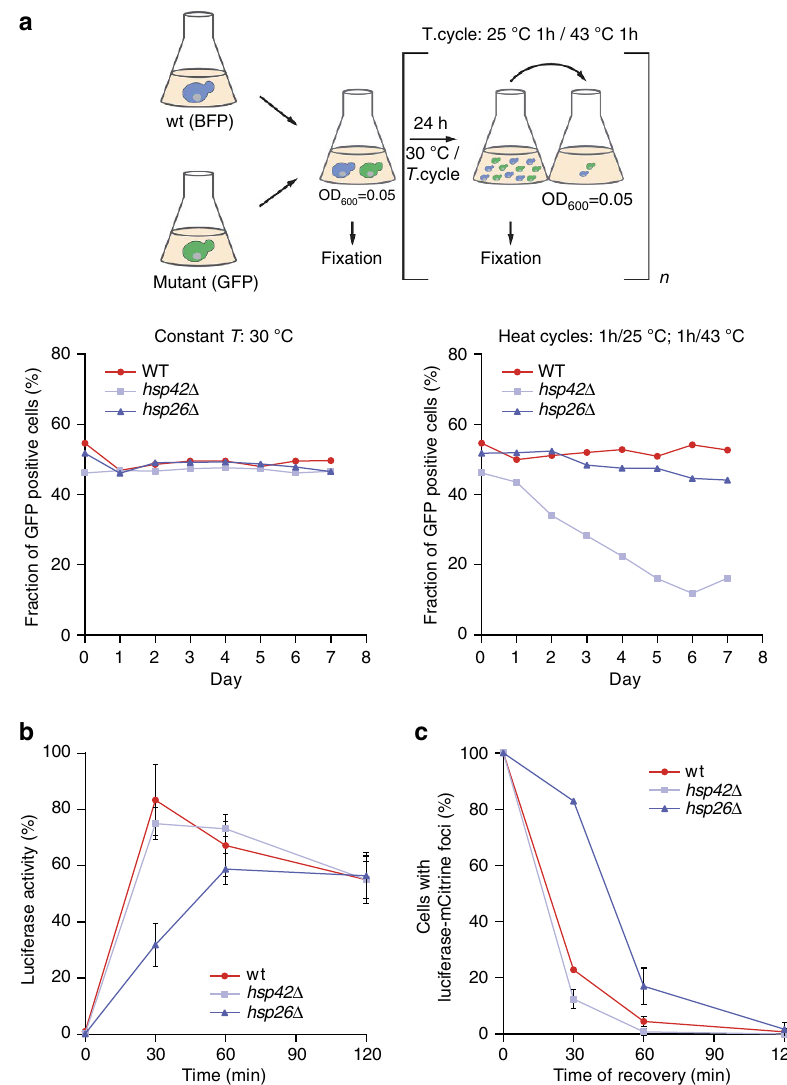
Figure 6 | Hsp26 accelerates protein recovery from aggregates and Hsp42 is beneficial for cell survival. ( a ) WTcells, expressing BFP, and respective mutant cells, expressing GFP, were grown to mid-log phase, mixed 1:1 and diluted to OD 600 0.05. The mixed culture was equally split and both were grown for seven days with daily dilutions to OD 600 0.05. One culture was grown at 30 (cid:2) C (left), the other culture was subjected to temperature cycles switching between 1h at 25 (cid:2) C and 1h at 43 (cid:2) C (right). Each day the proportion of WT and mutant cells was measured by monitoring the fraction of GFP- and BFP-positive cells by FACS analysis. ( b ) Effect of Hsp26 on luciferase recovery. Cells expressing yEMCitrine-luciferase in the respective genetic backgrounds were subjected to heat shock and allowed to recover. The graph shows the luciferase activity during recovery at 30 (cid:2) C. Cycloheximide was added before the heat shock. Mean and s.d. of three independent experiments are shown. ( c ) Heat-induced luciferase aggregates are dissolved more slowly in D hsp26 strain than in wild type or D hsp42 strains. Quantification is based on microscopy experiment (Supplementary Fig. 10b–d) and on analysis of B 100 cells per strain. After heat application (pre-shock for 45min at 37 (cid:2) C and subsequent heat shock for 20min at 45 (cid:2) C) cells recovered at 30 (cid:2) C. Relative ratios of cells with luciferase foci during recovery in respective strain backgrounds are shown. s.d. is